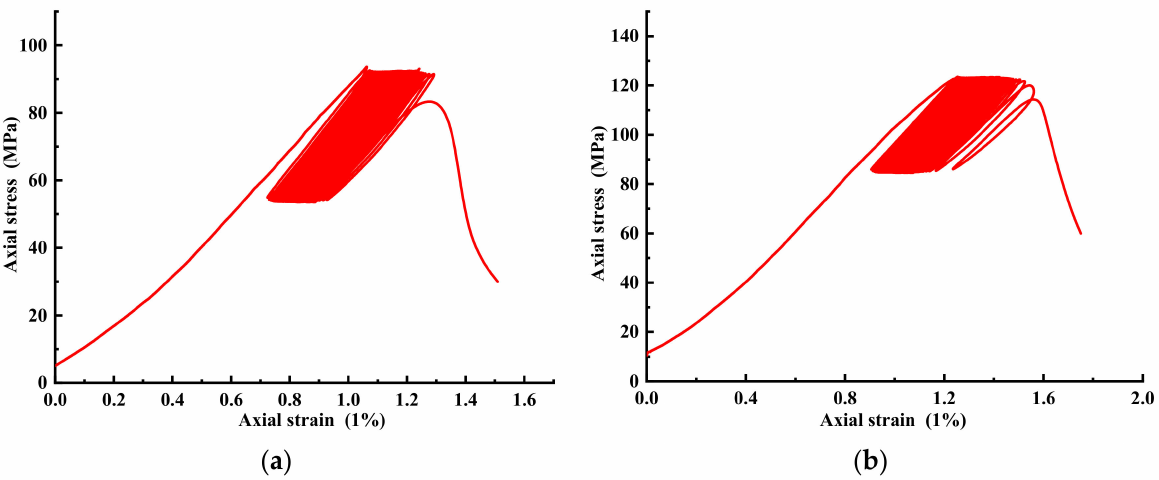
Figure 13. Fatigue stress–strain curves of sandstone under different confining pressures. ( a ) Sample F3-2; ( b ) Sample F3-3.